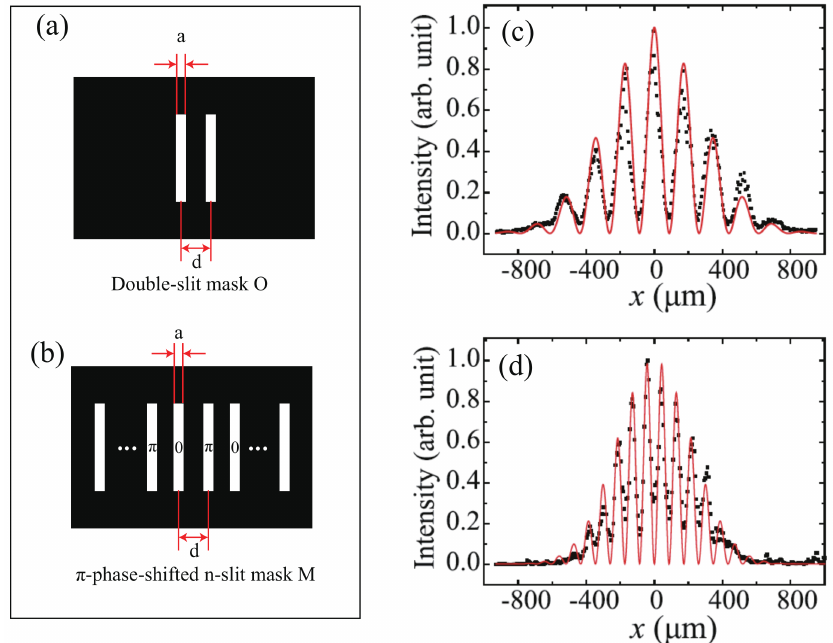
Figure 8. Schematic diagram of a double-slit mask O ( a ) and a π -phase-shifted n -slit mask M ( b ) with the same slit separation distance, d , and slit width, a . ( c ) is the normalized intensity profile of the interfering fringes of a double slit on the rear focal plane of lens L1, and ( d ) shows the normalized intensity profile of the corresponding subwavelength interference fringes by modulating the readout beam with a π -phase-shifted double-slit M. The slit separation distance and the slit width are d = 1000 µ m and a = 200 µ m, respectively, and the focal length of lens L1 is f 1 = 30 cm. ( c , d ) reproduced from reference [103]. CC by